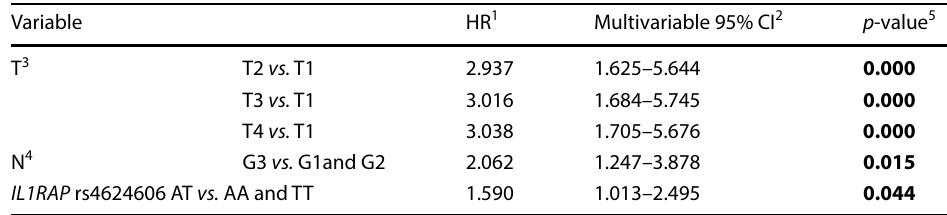
Table 5 Association between study variables and LSCC patients’ mortality in the final multivariable Cox proportional hazard model after the Backward